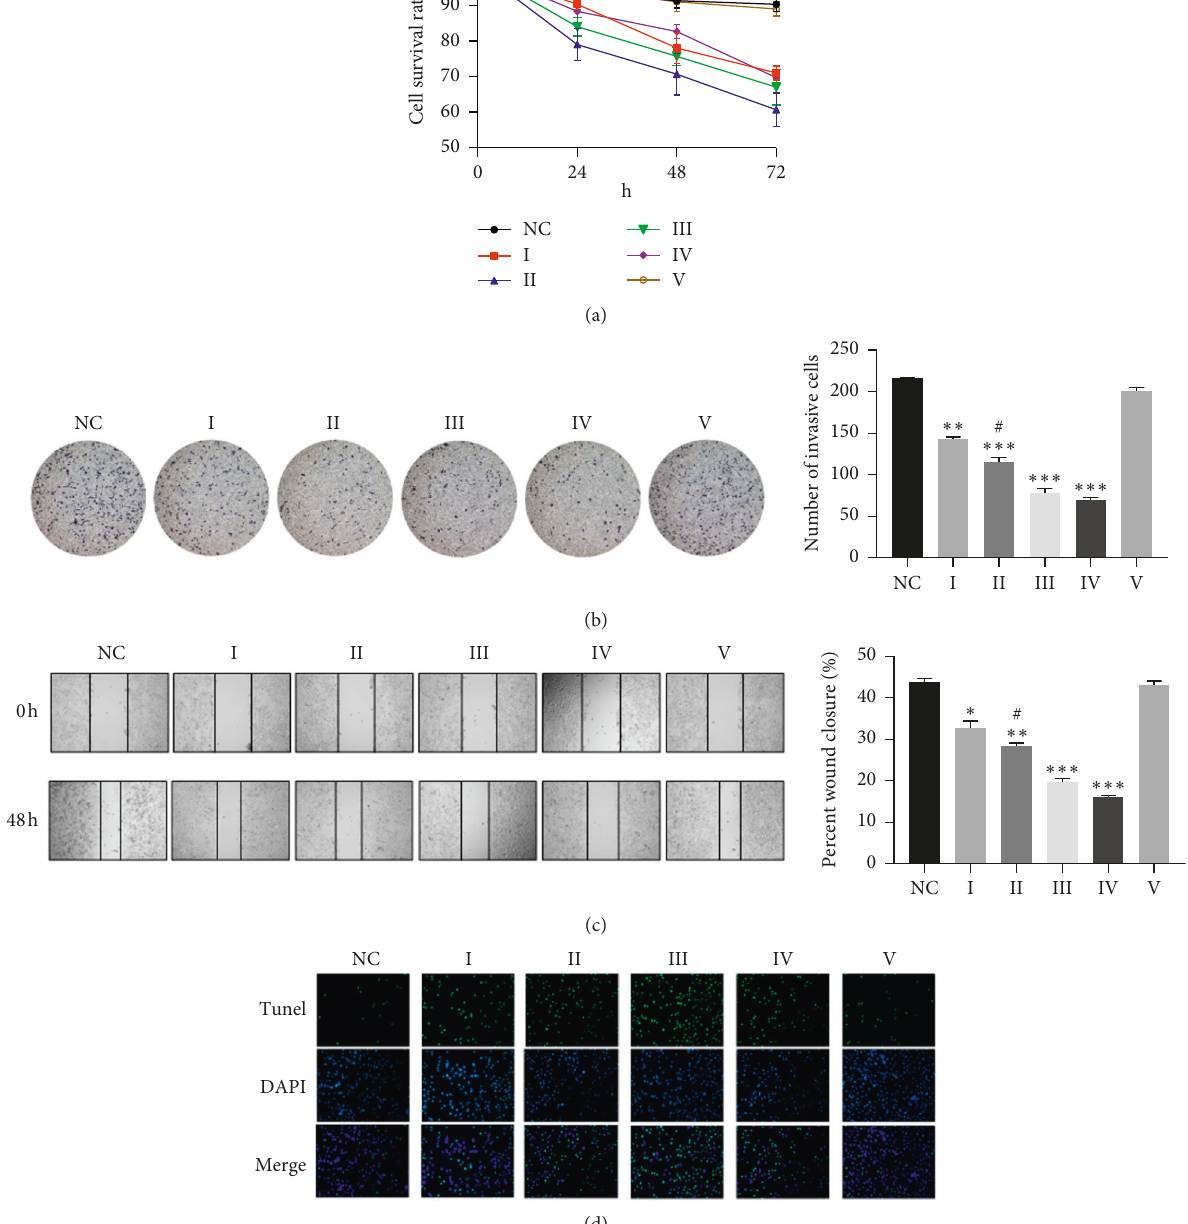
Figure 4: Mechanism of action of HA-Rg3 bio-polymerized nanoparticles on non-small-cell lung cancer. (a) H125 cells proliferation activity; (b) the invasion of H125 cells detected by Transwell assay; (c) the migration ability of H125 cells detected by wound healing; (d) the apoptosis of H125 cells was measured by Tunel assay. Groups (I) II, III, IV, and V were Rg3, HA-Rg3, miR-192 inhibitor, pc-PTEN, and miR-192 inhibitor+sh-PTEN, respectively. ∗∗ P < 0 . 01 vs the NC